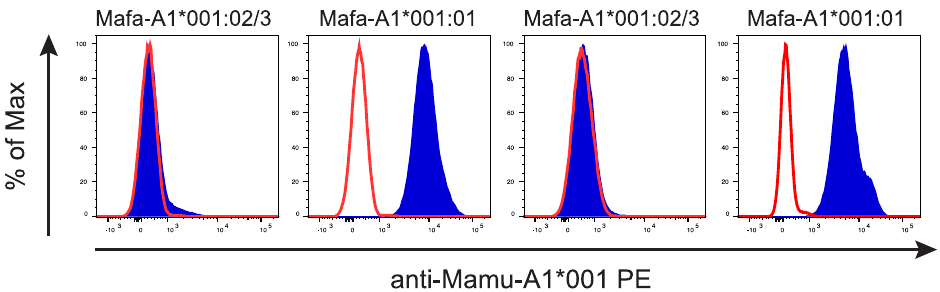
Fig 8. The P12 antibody differentially binds Mafa-A1 * 001variants. PBMC from four cynomolgus macaquesexpressingthe Mamu-A1 * 001 orthologMafa-A1 * 001 were stainedwith PE-labeled P12 antibody (blue traces) or left unstained(red traces). The P12 antibodyonly bound cells from animalsexpressingthe Mafa-A1 * 001:01allomorphbut not the Mafa-A1 * 001:02/03variants. The Mafa-A1 * 001 allelevariant that each animal expressedis listed above each